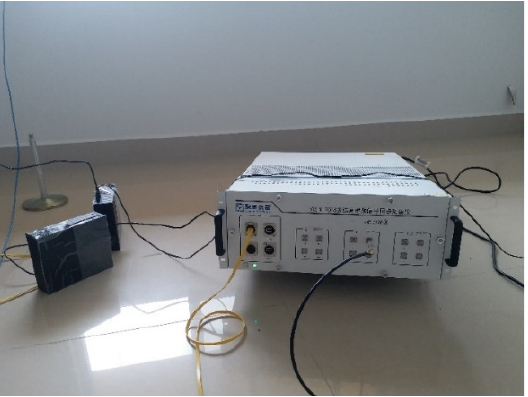
Figure 9. Multi-channel RF signal synchronization collector (VISN-7678).